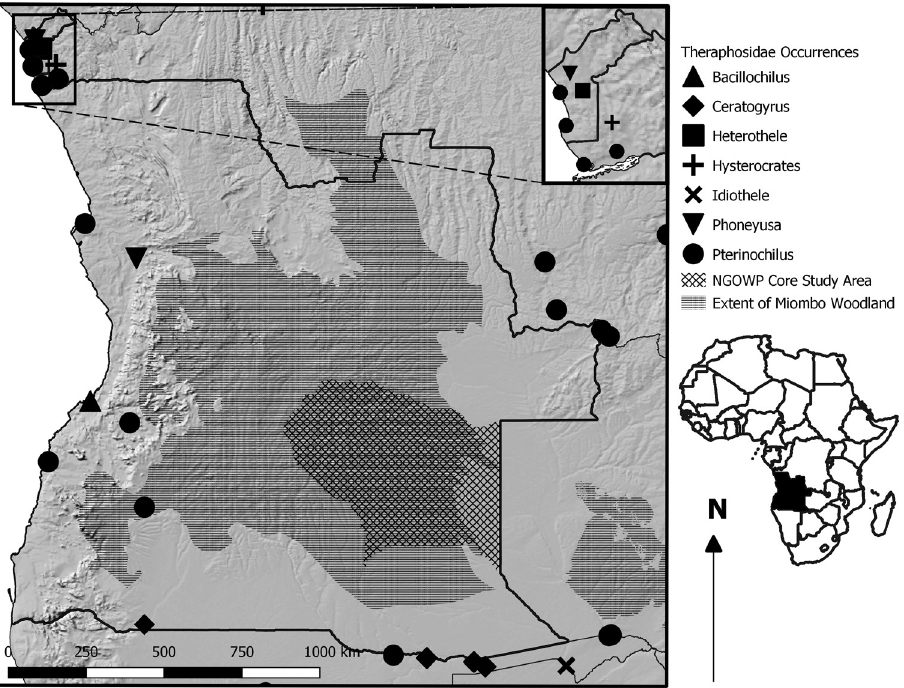
Figure 1. Map of the Okavango Wilderness Project study region in south-eastern Angola, known records of baboon spiders (Araneae: Theraphosidae) for Angola and adjacent parts of neighbouring countries, and extent of miombo woodland. Inset shows Cabinda Province. Prepared in QGIS V3.2 using publicly avail- able spatial layers from the World Wildlife Foundation (Olson et al. 2001), www.naturalearthdata.com and www.mapcruzin.com. Background is shaded relief.